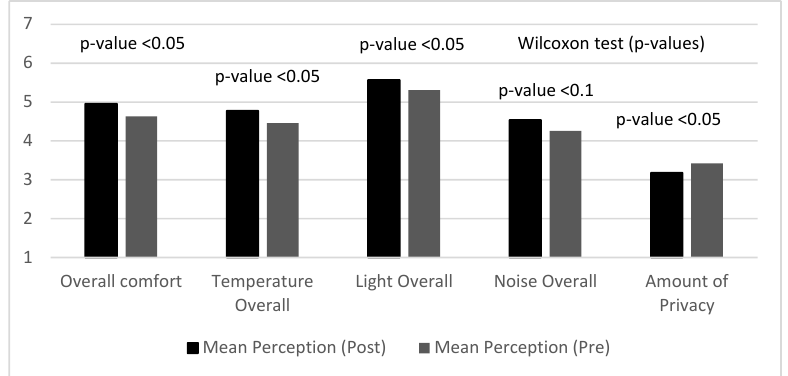
Figure 7. Comparison of IEQ parameters perception in workplace before and after COVID-19 countermeasures. In the last part of the questionnaire, participants expressed their degree of acceptance of the lockdown aspects due to the pandemic, and the results are presented in Table 3. In general, office occupants agreed to the applied polices and they seemed to accept the new conditions in their offices (mean score above the neutral score 3). On the other hand, at the time of the survey, they reported that they do not prefer to work from their homes anymore (score 2.54). The acceptance of new working conditions and the aspect of how the rest of the occupants in their office accept them, showed significant statistical correlation with their overall comfort (Spearman cor. 0.185, p < 0.01 and 0.370 p < 0.01). The occupants’ acceptance of the COVID-19 countermeasures application, in order to ensure a healthy and safe environment at work, was significantly correlated to all overall IEQ parameters. Similar results were revealed as to whether participants believed that their colleagues considered the COVID-19 situation to be serious. These new findings were also reported in a study conducted in offices in Japan during the pandemic period, where it was highlighted that increasing satisfaction with COVID-19 countermeasures may increase occupants’ performance in the offices [7]. Higher acceptance levels of the parameters, such as feeling comfortable in returning to workplace and the application of systems for social distancing and COVID-19 protection, resulted in fewer health complaints (Spearman cor. − 0.246 p < 0.01 and − 0.180 p < 0.01, respectively). As is depicted in Figure 8, the social distancing protocol, use of masks and sanitizers (personal or stations) and the installation of barriers between the occupants were three of the most commonly applied protocols in the offices. Table 3. Correlations between IEQ comfort and degree of acceptance of the lockdown aspects.